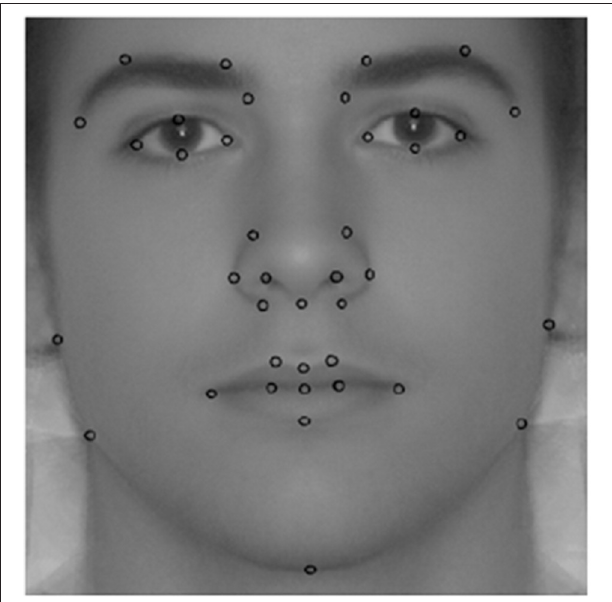
FIGURE 2 | Facial landmarks used to compute